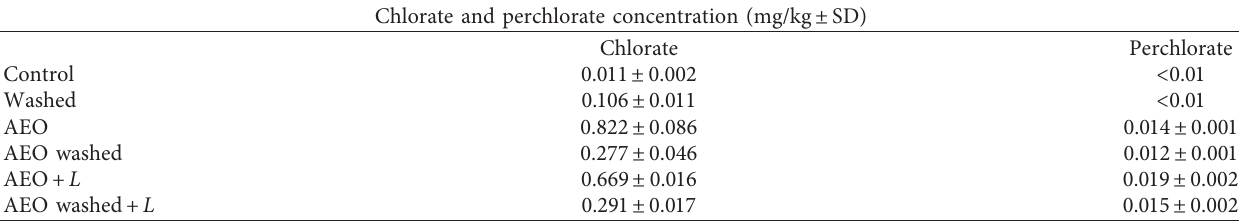
Table 4: Measurement of residual chlorate and perchlorate concentration of unwashed and washed samples following treatment. Chlorate and perchlorate concentration (mg/kg ± SD)